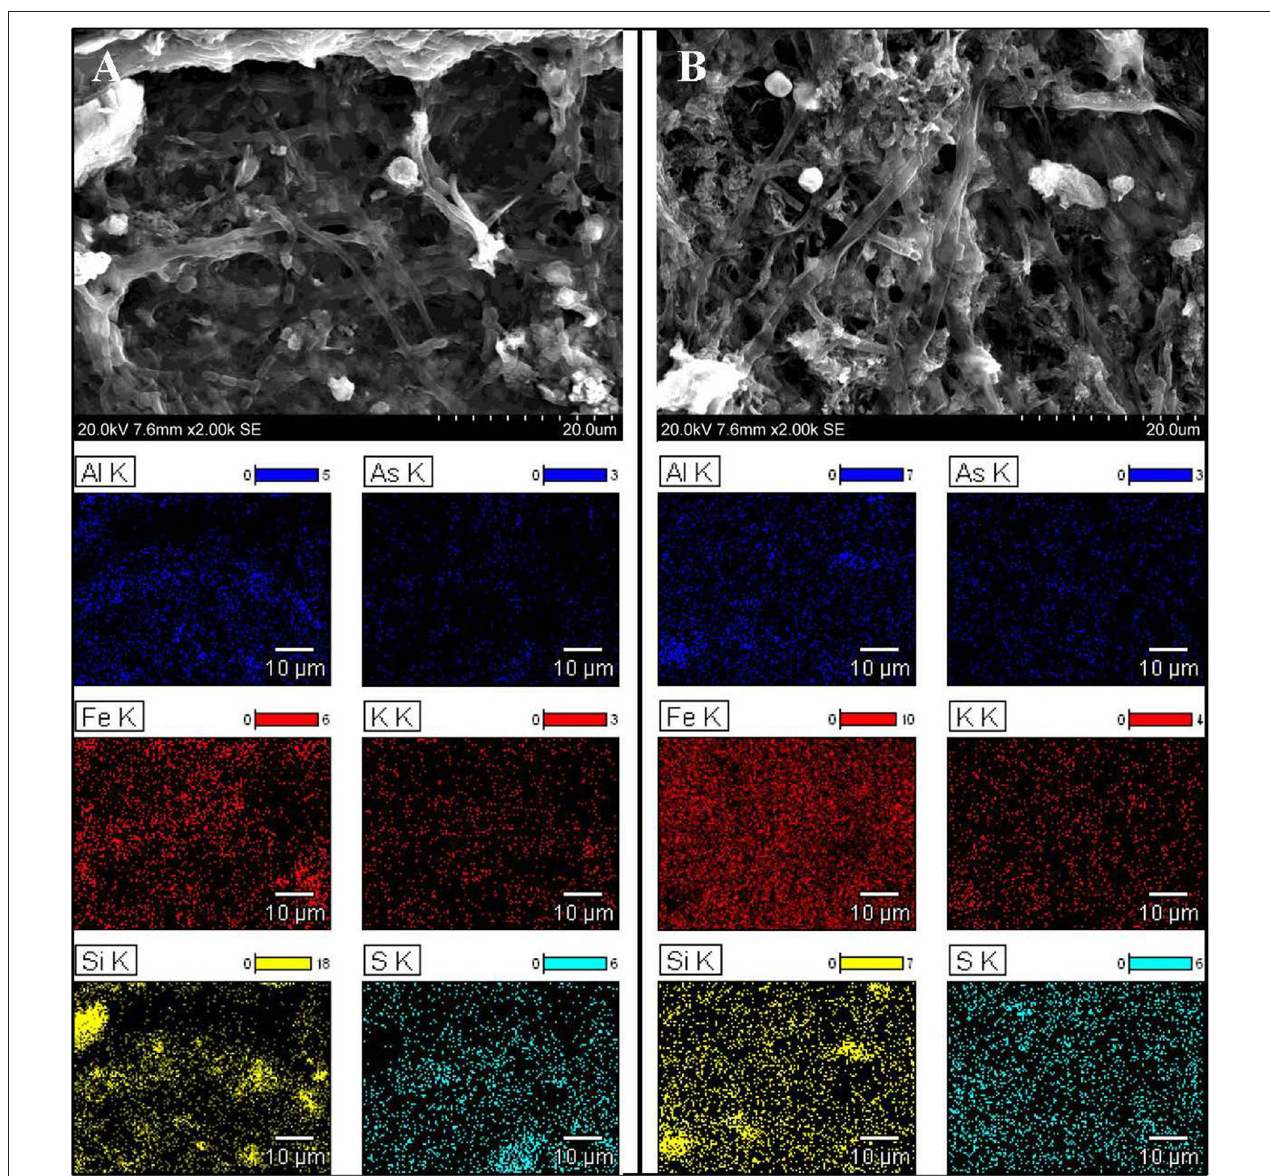
FIGURE 1 | Morphology and distribution of chosen elements in microbial mats. Scanning electron micrographs and energy-dispersive X-ray spectroscopy results showing the structure and distribution of chosen elements in microbial mats from (A) ZS and (B)